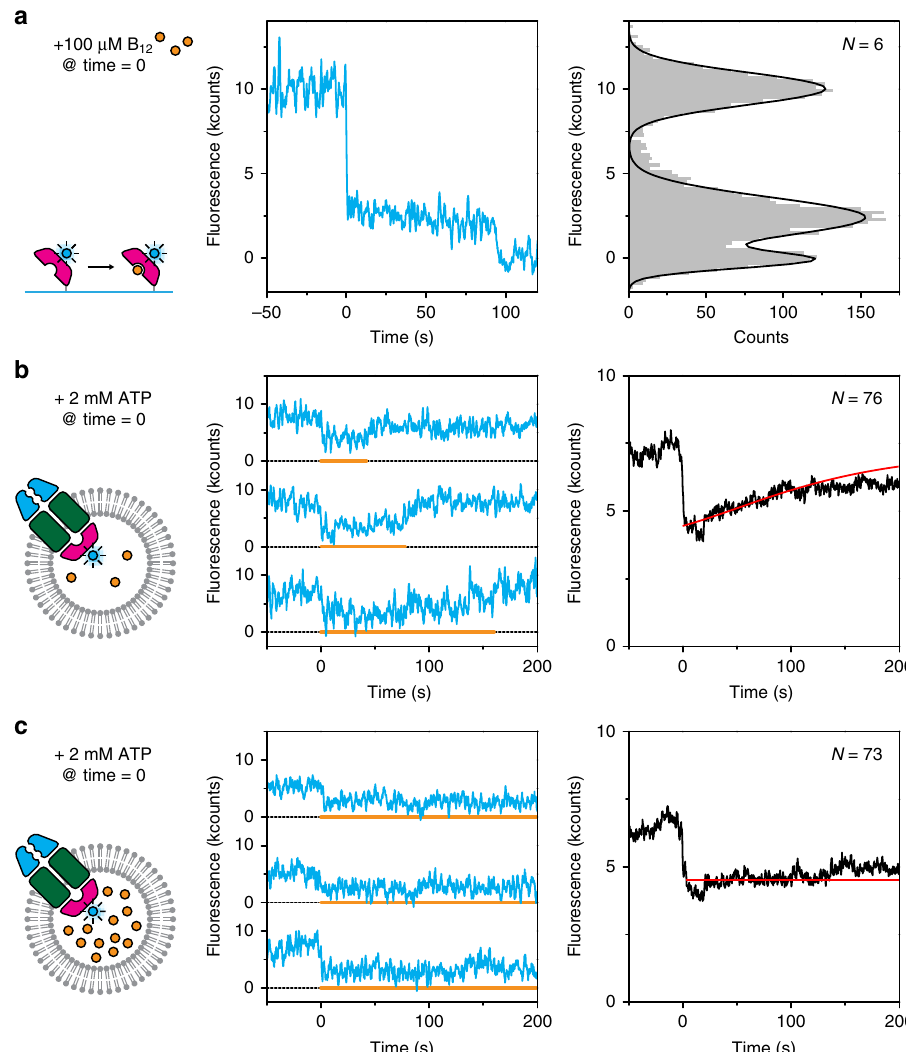
Fig. 4 Transport of vitamin B 12 observed with fl uorescence quenching. a Dye quenching by vitamin B 12 . His-tagged BtuF labelled with Alexa Fluor 488 was immobilised on the glass surface via anti-His antibodies. Upon introduction of substrate, the fl uorescence was quenched (middle panel) before it bleached around 100 s. Fluorescence intensities were collected in a histogram (right panel) to show that the quenching effect was ~75%. b When unlabelled BtuCD was reconstituted in liposomes loaded with 10 µ M vitamin B 12 (~3 molecules) and BtuF labelled with Alexa Fluor 488, a decrease in intensity was observed upon introduction of ATP and Mg 2+ (middle panel). The orange line marks the periods of low fl uorescence and indicates when a substrate molecule was present in the transporter. Averaging all traces (right panel) shows a gradual increase in intensity, which we attribute to depletion of substrate from the liposome. For data analysis, see methods. c Similar experiment as described in b , but with ten times higher concentration of vitamin B 12 . Depletion as observed in b was not visible here. For each condition, more than roughly 1000 traces were decreasing distribution, the distribution of total residence times for multiple molecules is given by a rise-and-decay function (see Methods). Since the number of substrate molecules inside a liposome follows a Poisson distribution, the total residence time of all vitamin molecules in a single transporter in one proteoli- posome is described by a convolution of both aforementioned distributions. Summing all traces that show a decrease in fl uor- escence intensity upon addition of ATP, directly yields the cumulative convoluted distribution. We fi tted this distribution and extracted an average residence time of 40 ± 10 s per substrate molecule in the transporter (Fig. 4b, right panel; Methods). Independent of substrate concentration, fl uorescence traces of complexes that do not show an initial ATP-dependent quenching effect remain fl at, indicating that those transporters are unable to translocate vitamin (Supplementary Fig. 11).